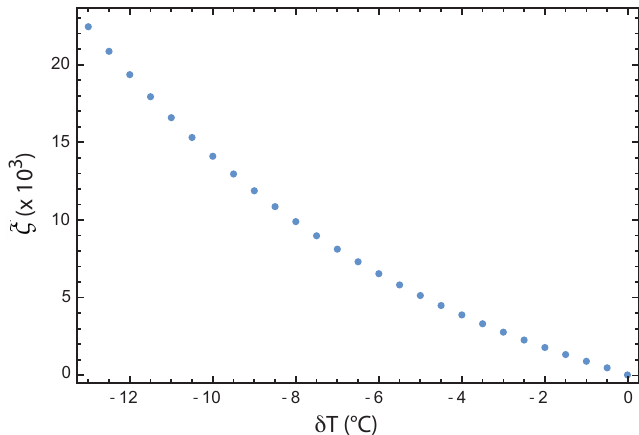
Figure 8. Dimensionless drag coefficient ξ predicted for an elementary edge dislocation in 8CB as a function of the temperature difference δ T = T − T NA . The calculations were performed by taking v = 20 µ m/s and by assuming that D ⊥ = 0. For D ⊥ = D (cid:107) , this coefficient is typically reduced by a factor of 1.5 (from Ref. [28], with kind permission of the European Physical